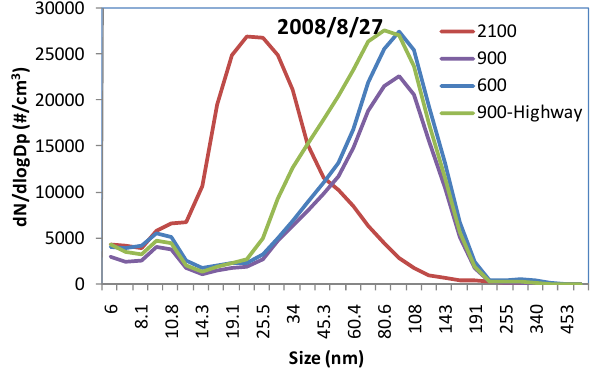
Fig. 9 The average size distribution of 5.6-560 nm particles at different heights on Fig. 9. The average size distribution of 5.6–560nm particles at dif- Aug. 27 flight (“900-Highway” means the average size distribution of particles ferent heights for the 27 August above highways and freeways at 900 m)